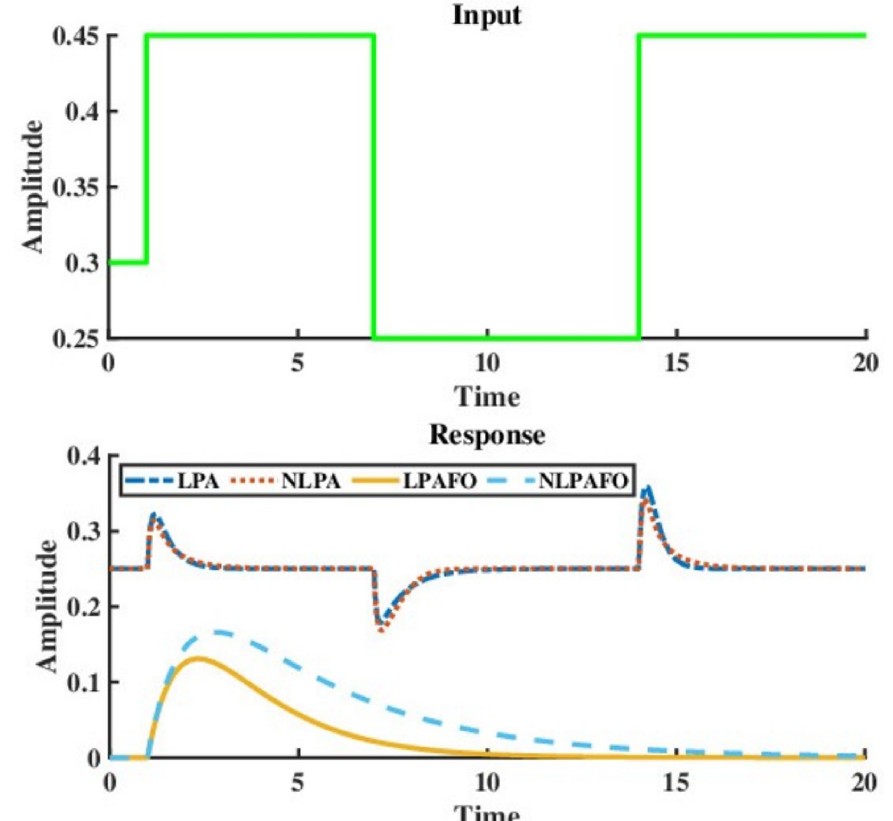
Fig 3. Two node networks capable of adaptation subject to staircase disturbance. The abbreviations LPA, NLPA, LPAFO, NLPAFO stand for linear perfect adaptation, non-linear perfect adaptation, linear perfect adaptation for once and non-linear perfect adaptation for once respectively. The network architecture and necessary values for this simulation have been provided in S1 Text.